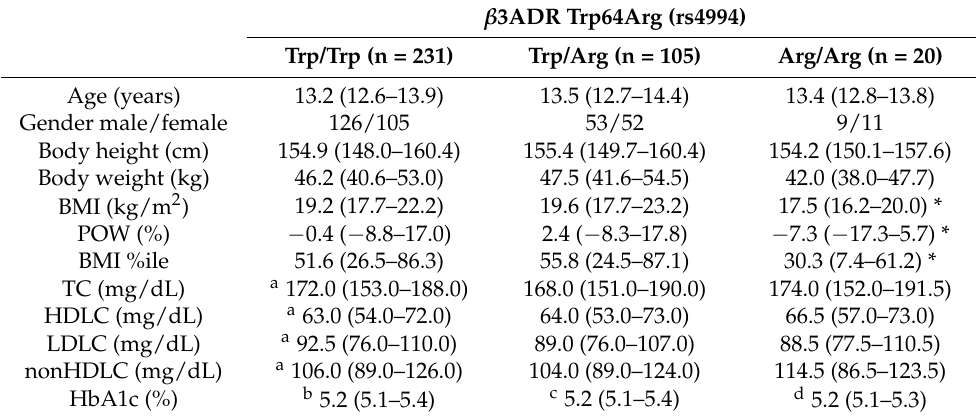
Table 6. Clinical characteristics of the β 3ADR Trp64Arg (rs4994) SNP